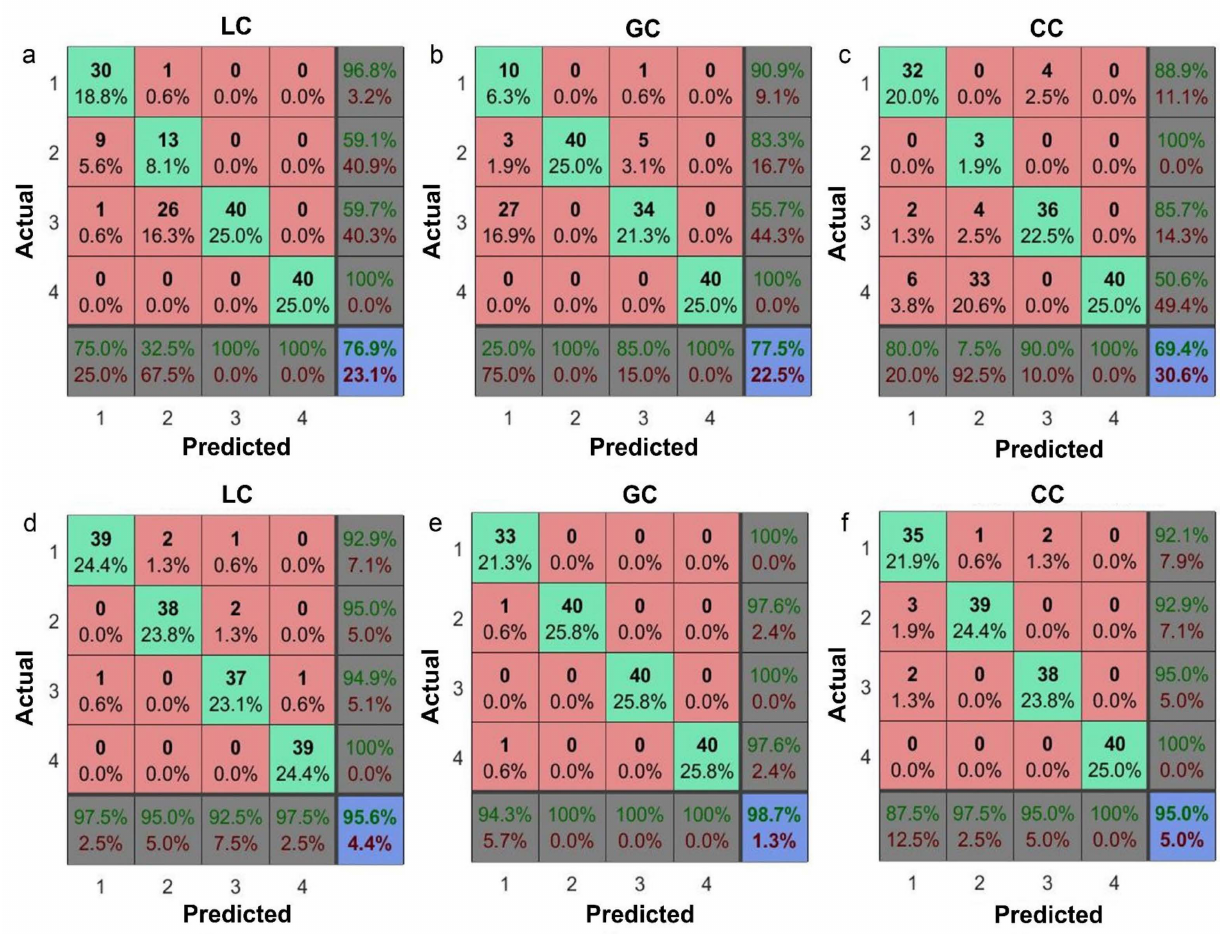
Figure 4. Confusion matrix of the prediction accuracy for SD-IR-based blood of DTC stages. ( a – c ) Prediction reports for the SD-IR absorbance feature dataset from patients with DTCs. ( d – f ) Prediction results of the optimized SD-IR absorbance + shift feature dataset. The 2D-SD-IR-BP algorithm exhibited the best performance. 1–4: represent detailed staging of patients with DTCs from Supplementary Table S1,